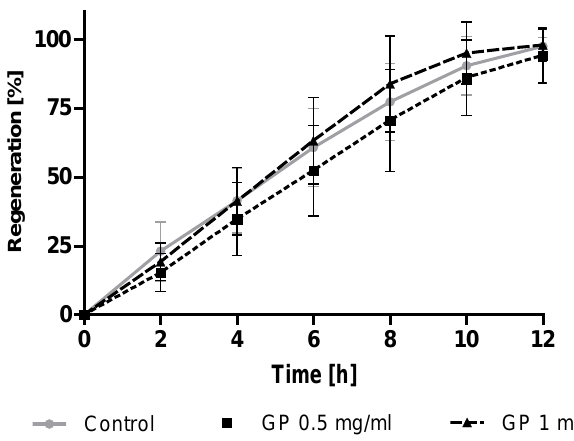
Figure 6. Effect of the G. parviflora extract (GP) on the regeneration of wound healing. Cells were treated with the GP extract or the vehicle control for 12 h and then assessed regeneration (time-lapse microscopy). The data were derived from eight independent experiments testing cell regeneration. The data expressed as a mean ± SD.